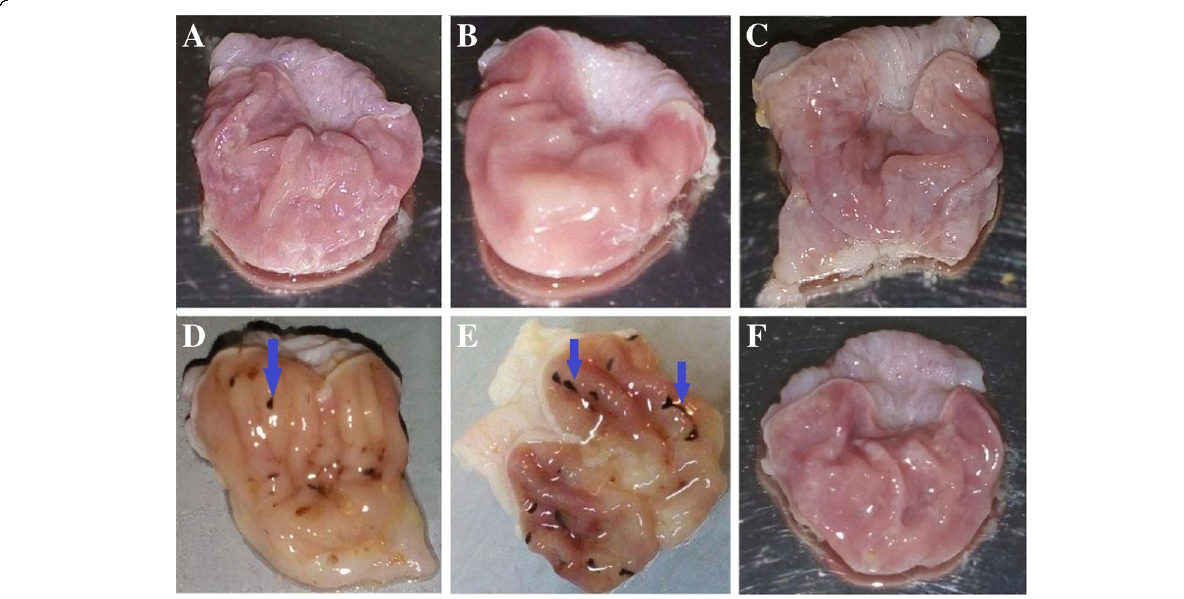
Fig. 2 The macroscopic images of the stomach from normal control rats ( a , b ), normal controls receiving CMC ( c ), indomethacin-induced gastric ulcer ( d , e ) and ulcerated rats receiving AW extract ( f ). The rats showed normal mucosa after treatment with AW extract. Arrows show linear